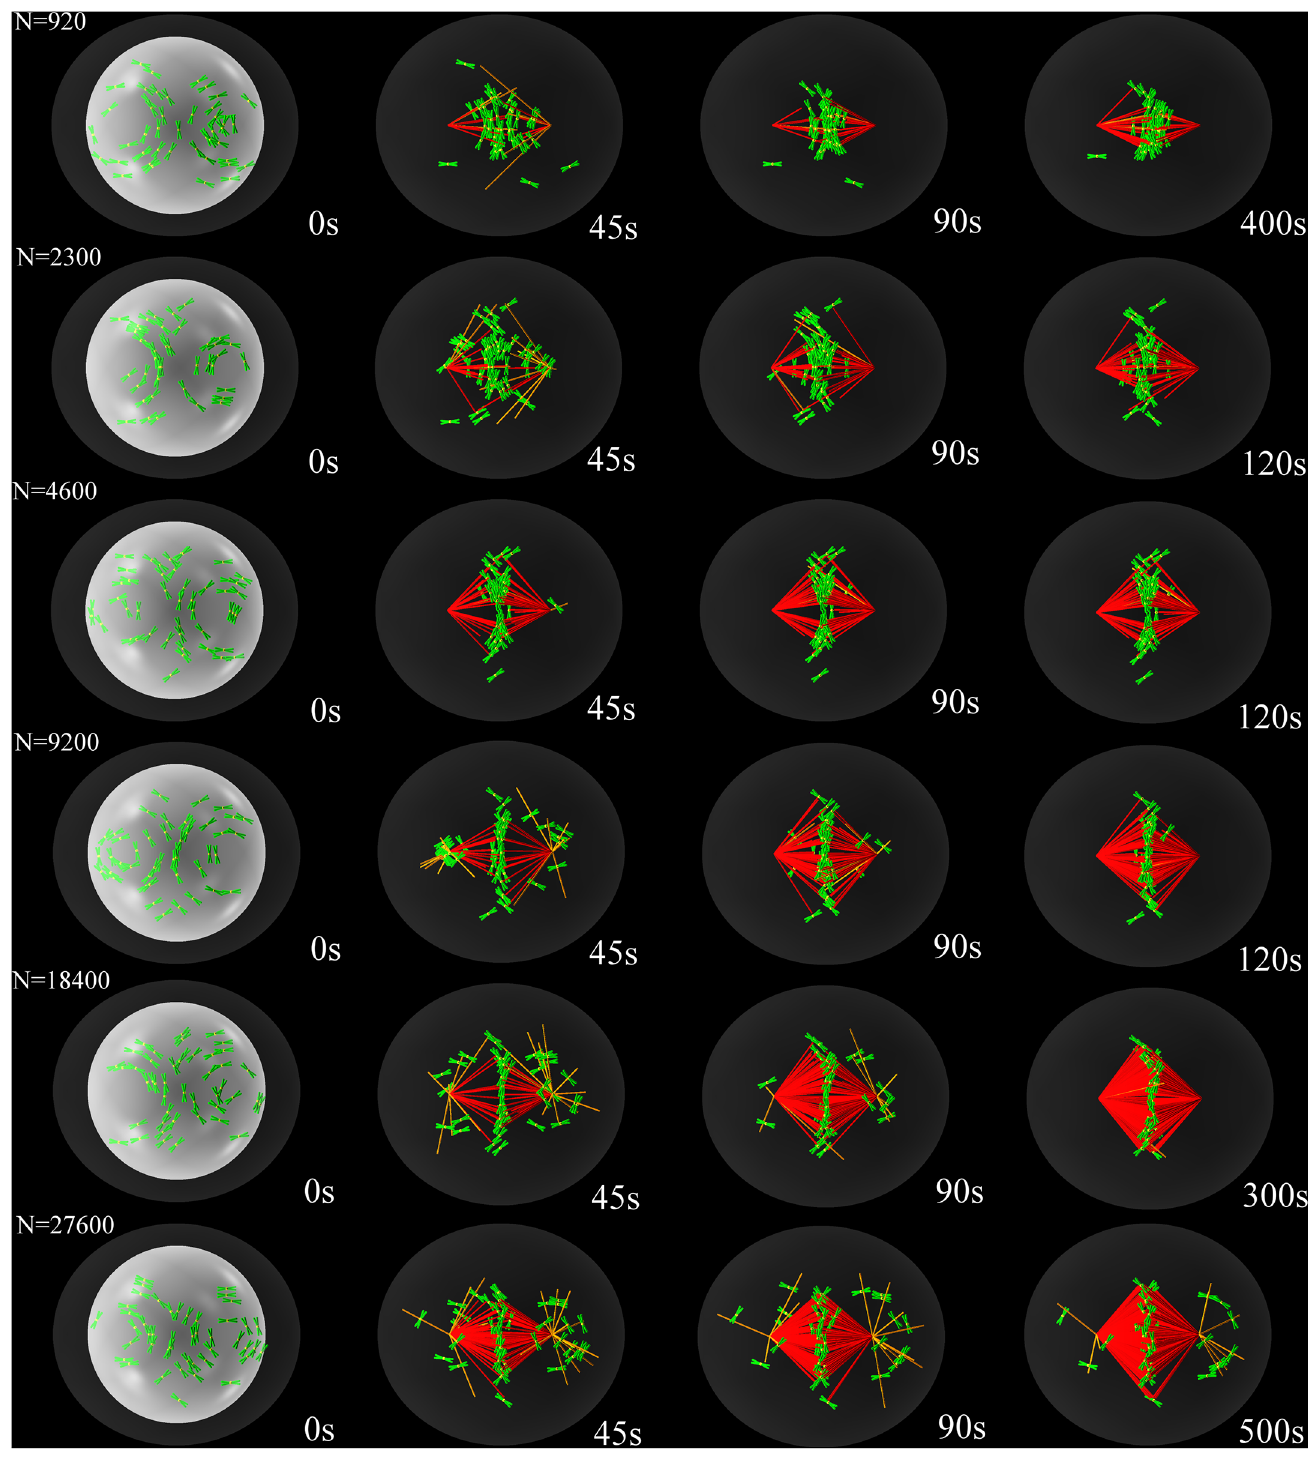
Fig 5. Time-lapse snapshots of the simulated congression process for different values of the number of MTs per kinetochore. Congression fails if this number is too small or too large. Chromosomes are shown as having chromatid arms (green) for viewing purposes, while the kinetochores are shown as yellow spheres. Not all MTs are shown, only those that serve as rails for kinetochore motor-proteins (orange) and end-on attached MTs (red). The nuclear envelope is shown for reference in each of the first panels as a white sphere. The cortex is represented in dark grey.